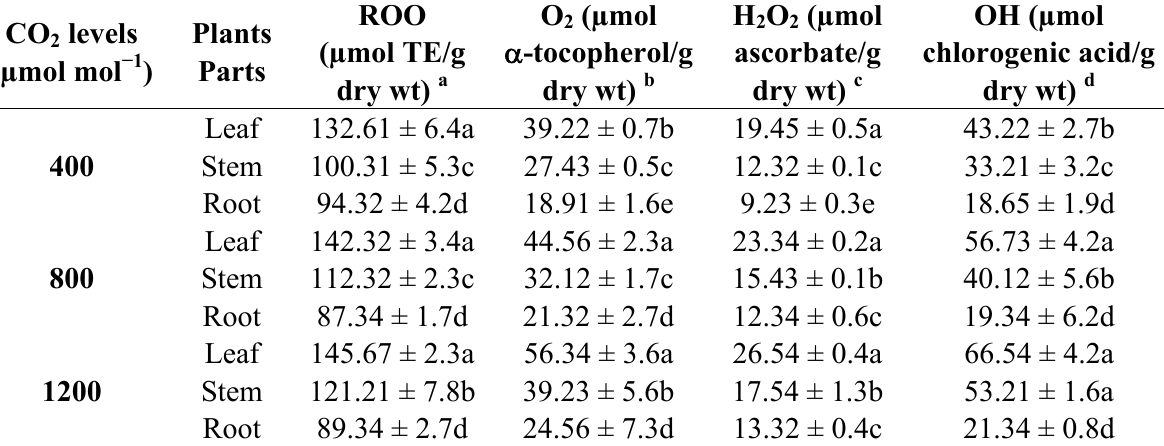
Table 2. Antioxidant activity against Peroxyl Radicals (ROO), Superoxide Radicals (O Hydrogen Peroxide (H O ) and Hydoxyl Radicals in different part of L. pumila under 2 2 different CO concentration. 2